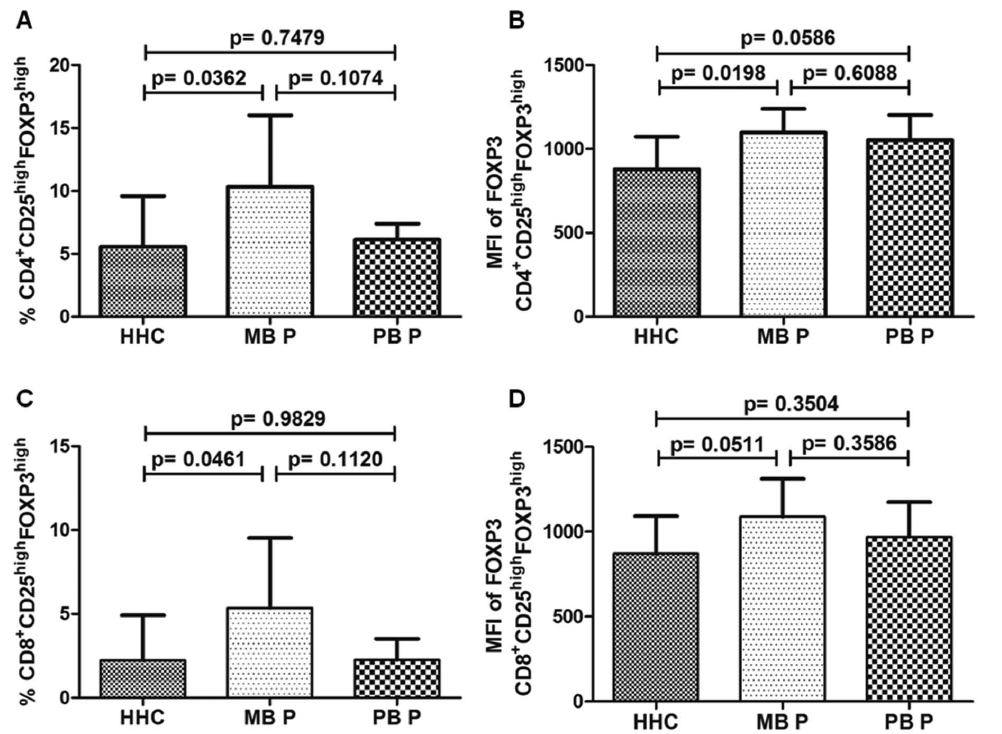
Figure 3. CD4 + /CD8 + CD25 high FOXP3 high cell frequency and FOXP3 mean fluorescence intensity (MFI) in leprosy patients and contacts. The frequency of Treg in CD4 + or CD8 + lymphocyte gate after 72-hour culture of peripheral blood mononuclear cells with anti-CD3 and anti-CD28 associated with total sonicated fraction of M. leprae. Comparison between household contacts (HHC), multibacillary patients (MB P) and paucibacillary patients (PB P), with regard to frequency of CD4 + CD25 high FOXP3 high (A) and CD8 + CD25 high FOXP3 high (C) cells and to FOXP3 MFI in CD4 + CD25 high FOXP3 high (B) and CD8 + CD25 high FOXP3 high (D) cells. Unpaired two-tailed Student t-test, p # 0.05 was considered significant. Results are presented as mean with